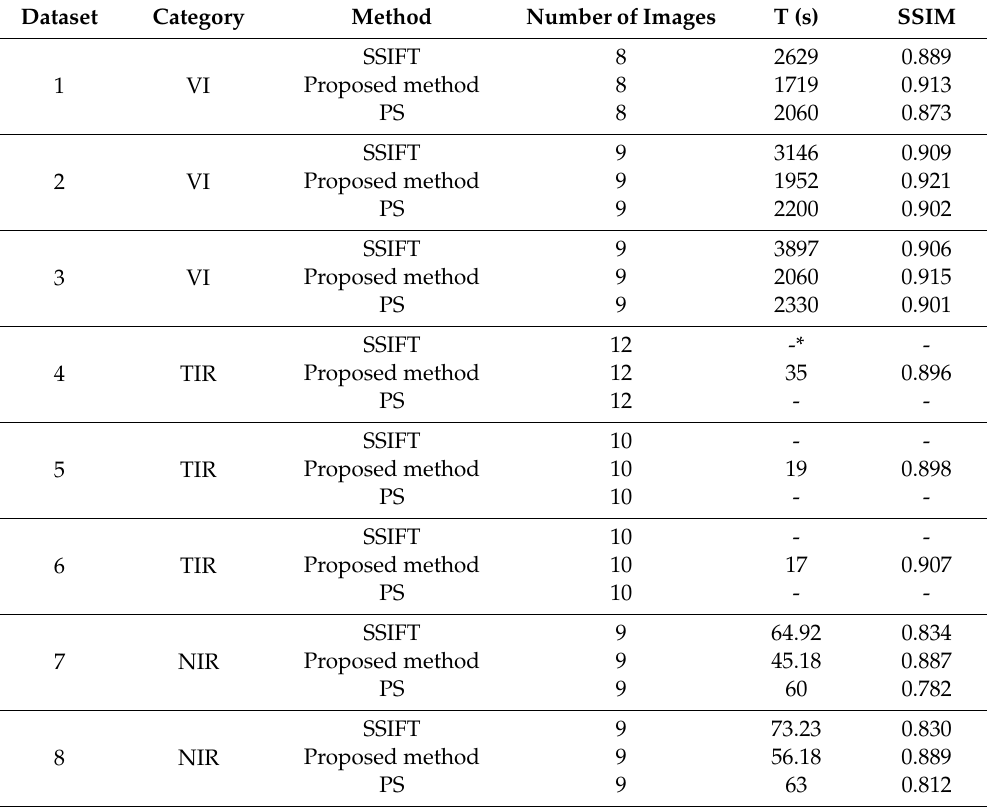
Table 2. Results of mosaicking UAV images for the crop growth monitoring experiment.